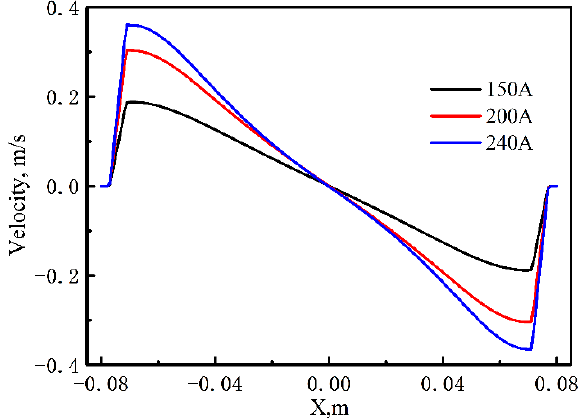
Figure 7. Tangential velocity profile along X direction at center plane of the M ‐ EMS.